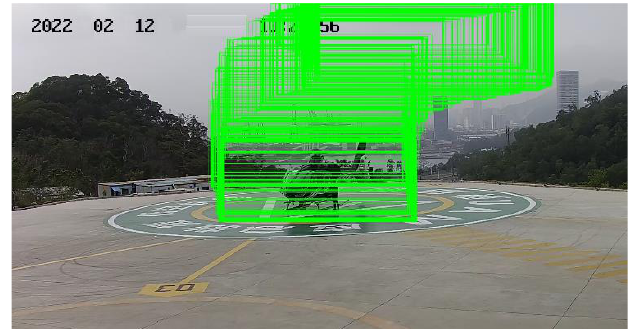
Figure 6. Bounding box effect with stillness as background.